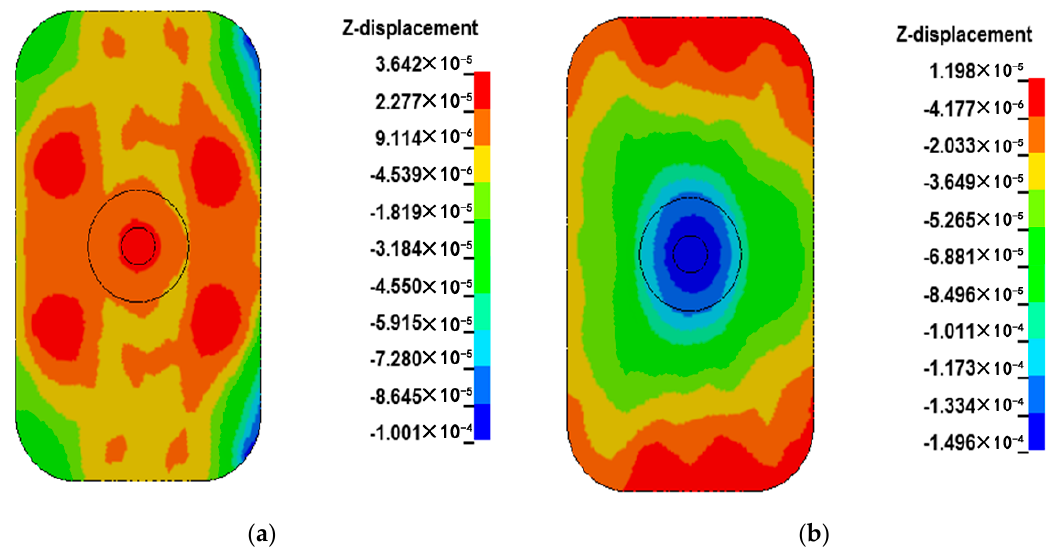
Figure 21. Deformation under 100 Hz. ( a ) plate deformation distribution at the upper half cycle maximum. ( b ) plate deformation distribution at the lower half cycle maximum. The data for the mid-point of the short edge seam of the vertical column were extracted, and the displacement–time curve was drawn, as shown in Figure 22.